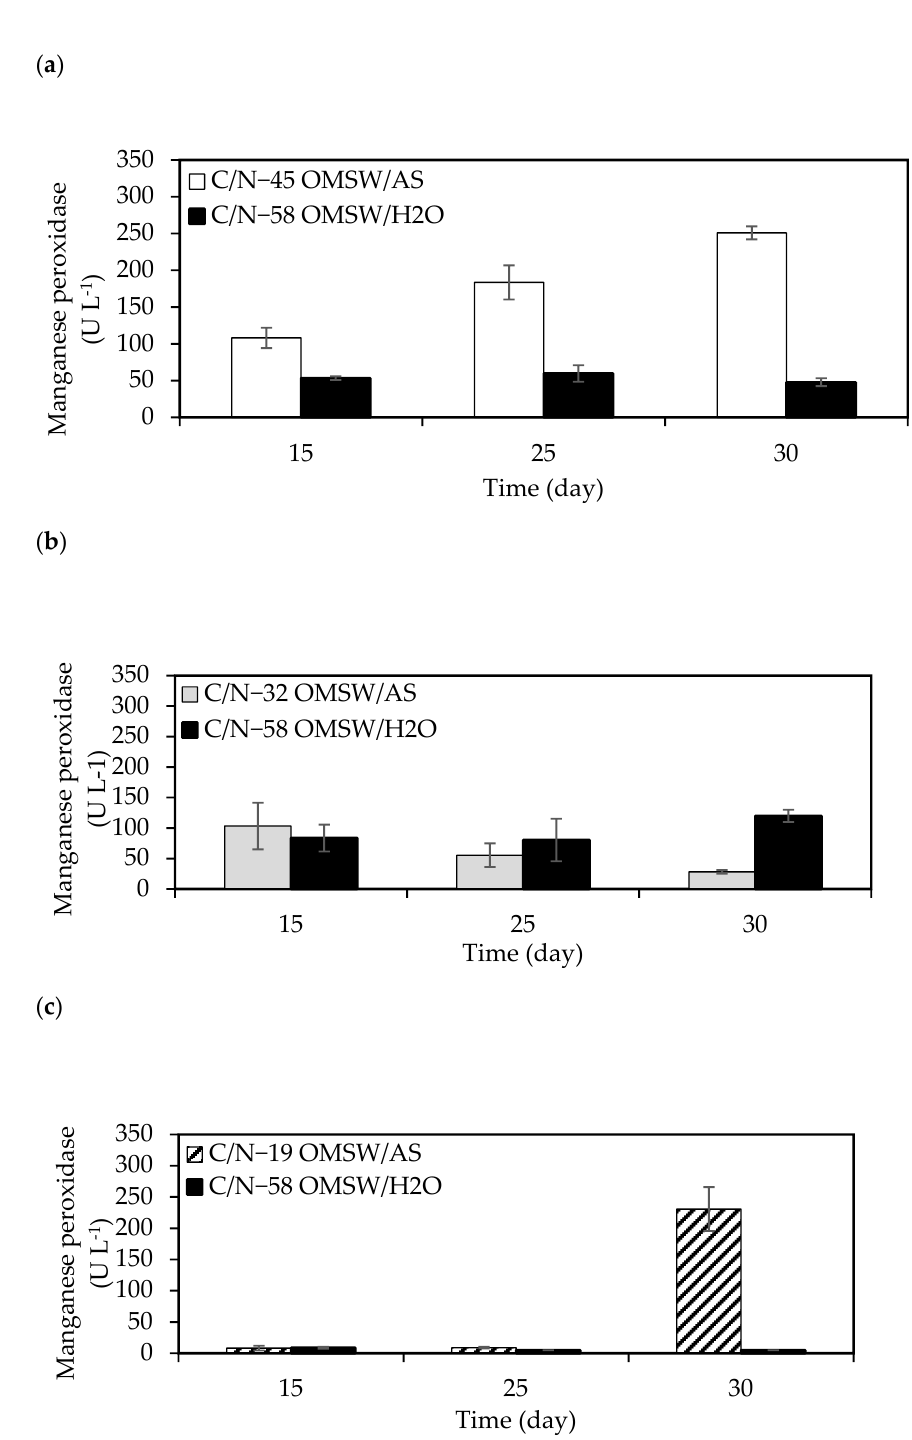
Figure 3. Comparison of manganese peroxidase activity at three control points (15, 25 and 30 days) for the OMSW/AS and OMSW/water mixtures at same concentrations; 171 ( a ), 75 ( b ) and 32 g TS L − 1 ( c ).